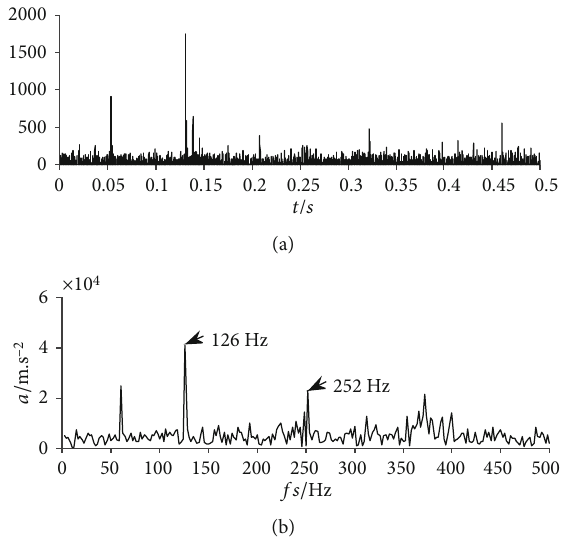
Figure 10: Waveform and frequency spectrum of bearing R 3 with an an outer ring defect signal denoised by a traditional morphological fi lter with large-scale structuring elements. (a) Waveform. (b) Frequency spectrum.